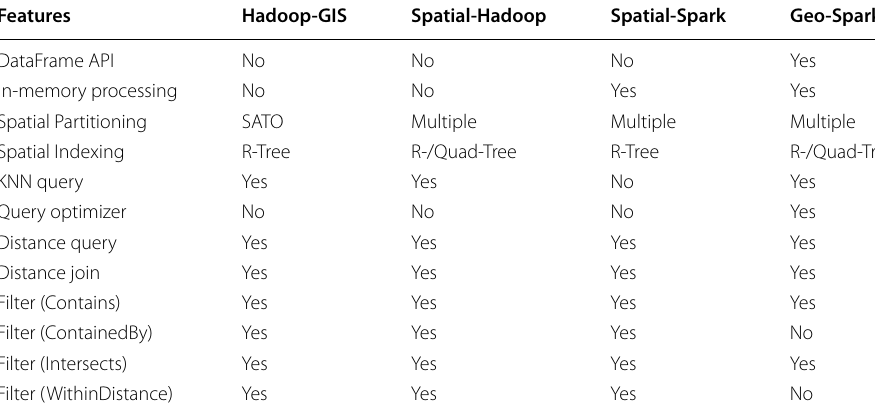
Table 5 Comparison among popular Spatial DB Framework